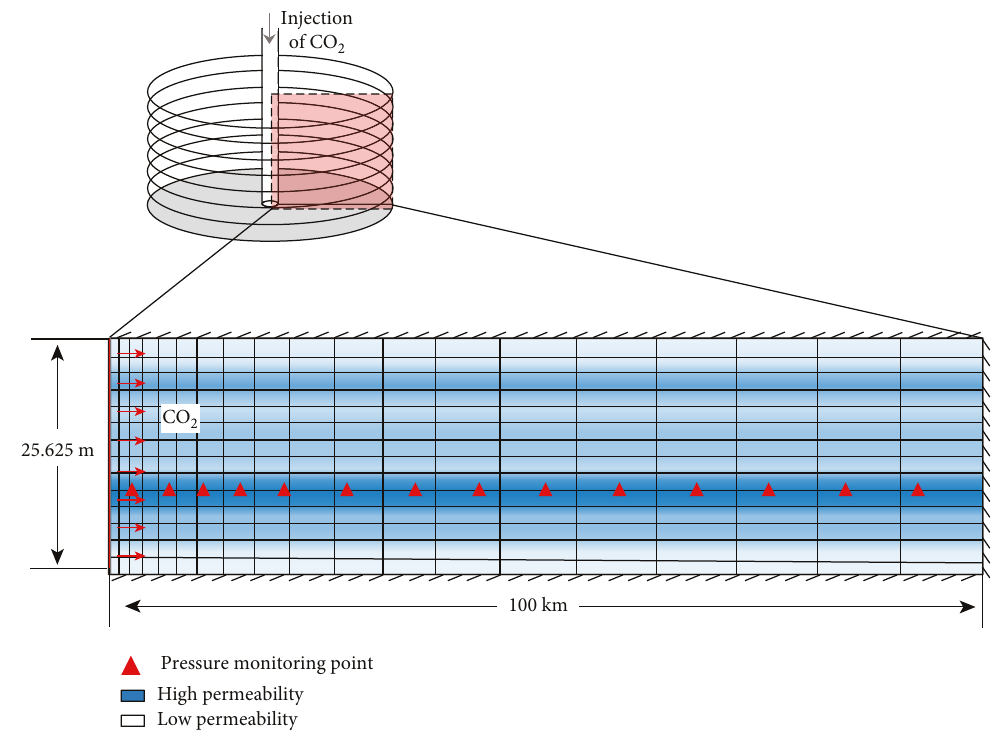
Figure 8: Positions of the pressure monitoring points in the radial